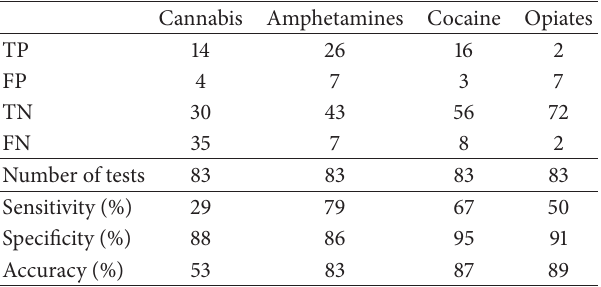
Table6:PerformancedataofDrugWipe5AincomparisonwithHS- SPME-GC-MS